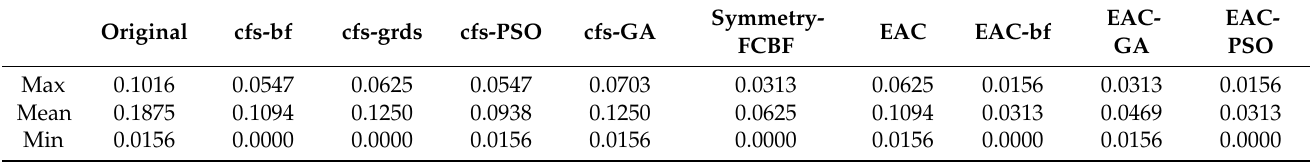
Table 3. Time consumption (in seconds) of the Hoeffding tree model coupled with ten preprocessing